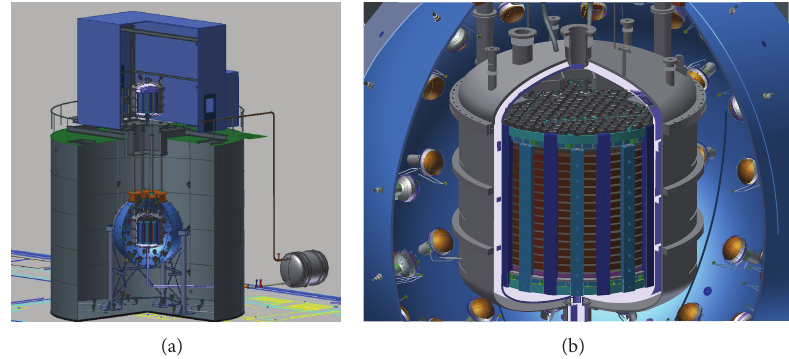
Figure 1: 3D model of the muon veto, neutron veto, and DarkSide-G2 LAr TPC (a), with a zoom on the TPC (b).